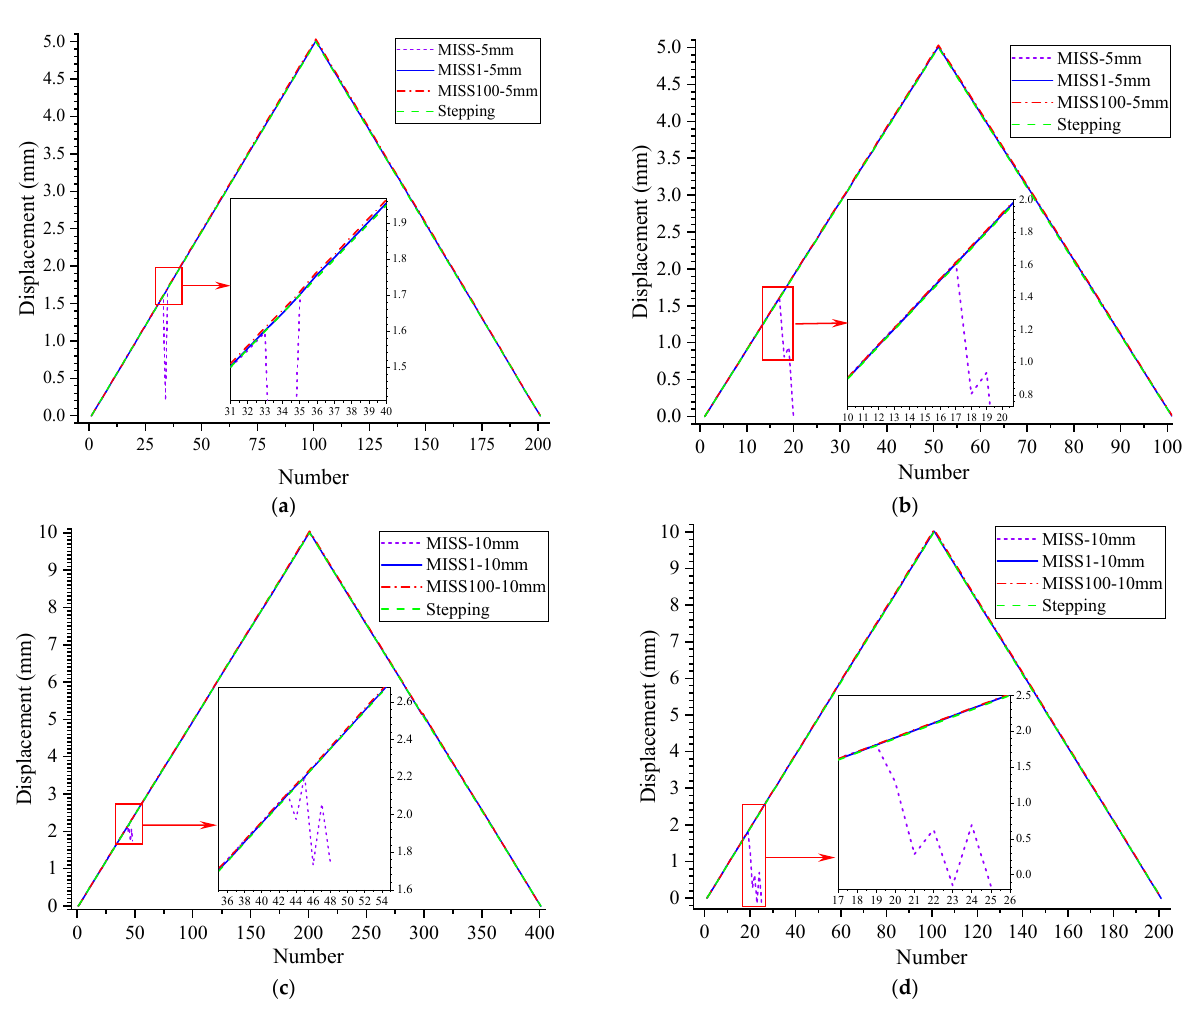
Figure 7. Comparison results of the displacement tests. ( a ) Displacement of 5 mm with a step of 50 µ m; ( b ) displacement of 5 mm with a step of 100 µ m; ( c ) displacement of 10 mm with a step of 50 µ m; ( d ) displacement of 10 mm with a step of 100 µ